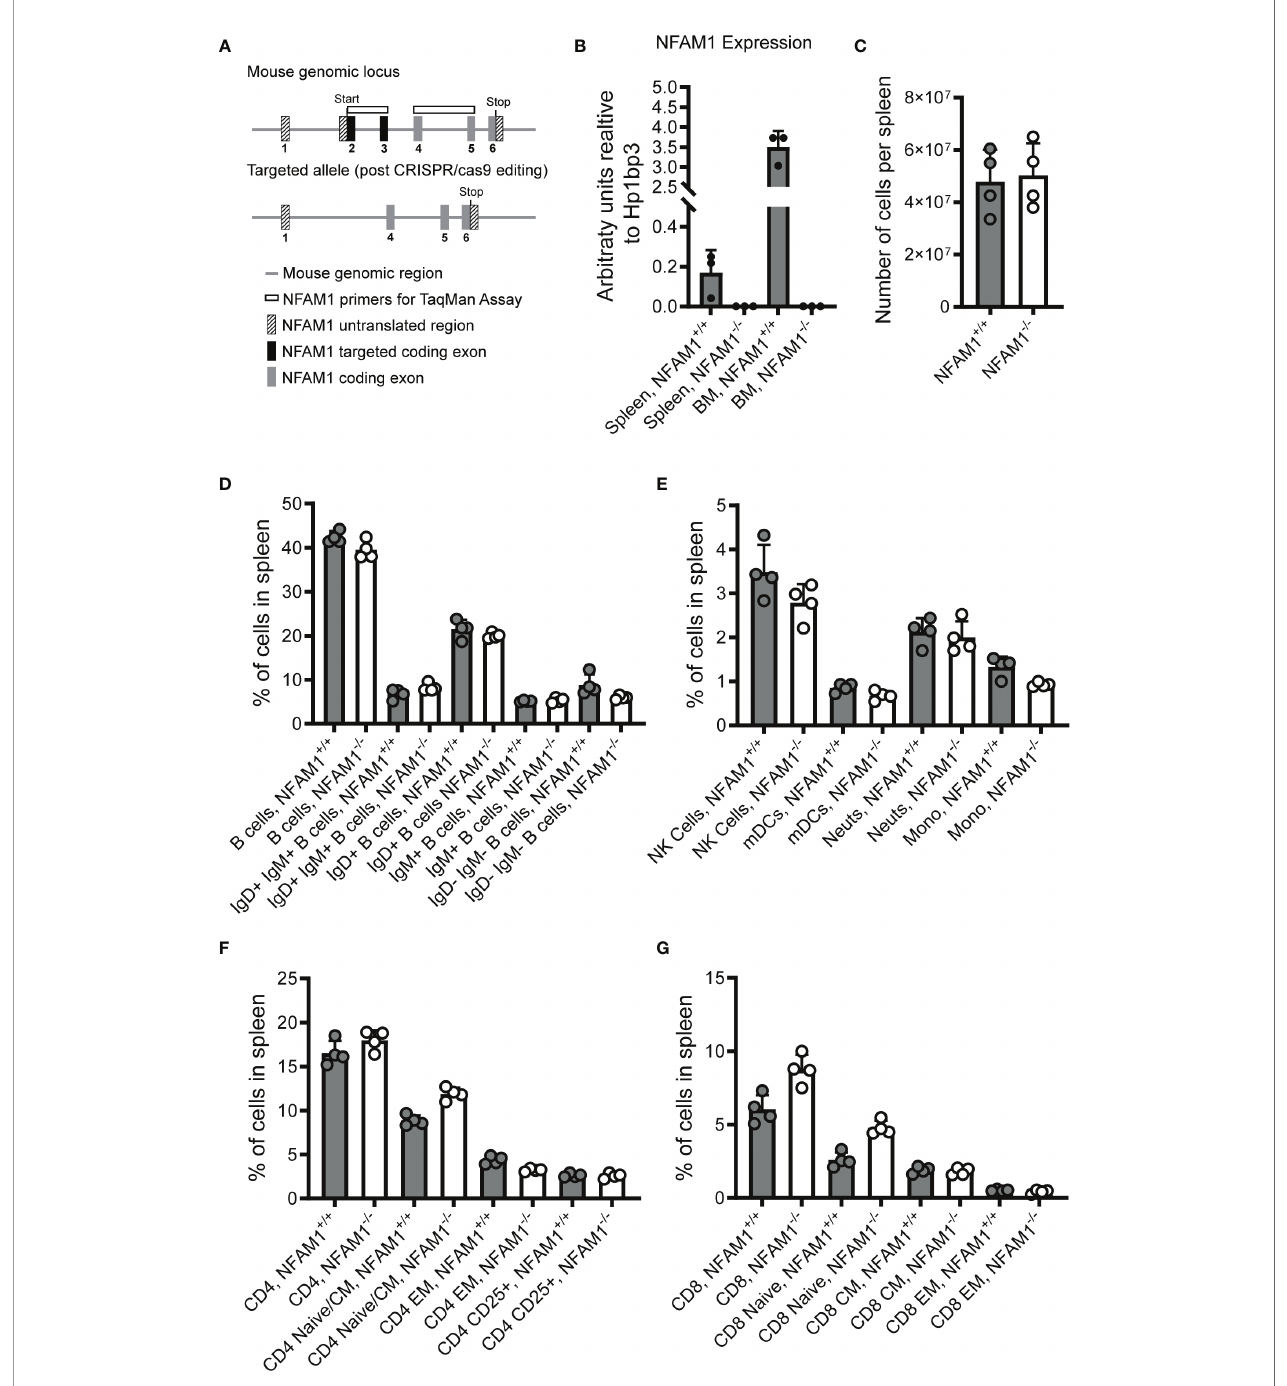
FIGURE 2 | Analysis of spleens from NFAM1 +/+ and NFAM1 -/- mice reveal no difference in percentages of innate and adaptive immune cells. Strategy for deletion of NFAM1 exons 2 and 3 via CRISPR-cas9 is shown in (A) . Mean expression of NFAM1 exons 2 and 3 in splenocytes and bone marrow from 3 NFAM1 +/+ and 3 NFAM1 -/- mice is shown in (B) . Splenocytes were isolated from 4 NFAM1 +/+ mice and 4 NFAM1 -/- mice. Mean number of cells per spleen in shown in (C) . Percentage of innate and adaptive immune cells were enumerated by fl ow cytometry. Mean percentage of B cells per spleen in shown in (D) , mean percentage of NK cells, myeloid dendritic cells (mDCs), neutrophils (neuts) and monocytes (mono) per spleen is shown in (E) , mean percentage of CD4 T cells is shown in (F) and mean percentage of CD8 T cells is shown in (G) . (C – G) Results are representative of two independent experiments. In the second experiment (data not shown), spleens from 9 NFAM1 -/- and 6 NFAM1 +/+ mice were analyzed with no statistically signi fi cant differences in the percentage of innate or adaptive immune cells between NFAM1 +/+ and NFAM1 -/-